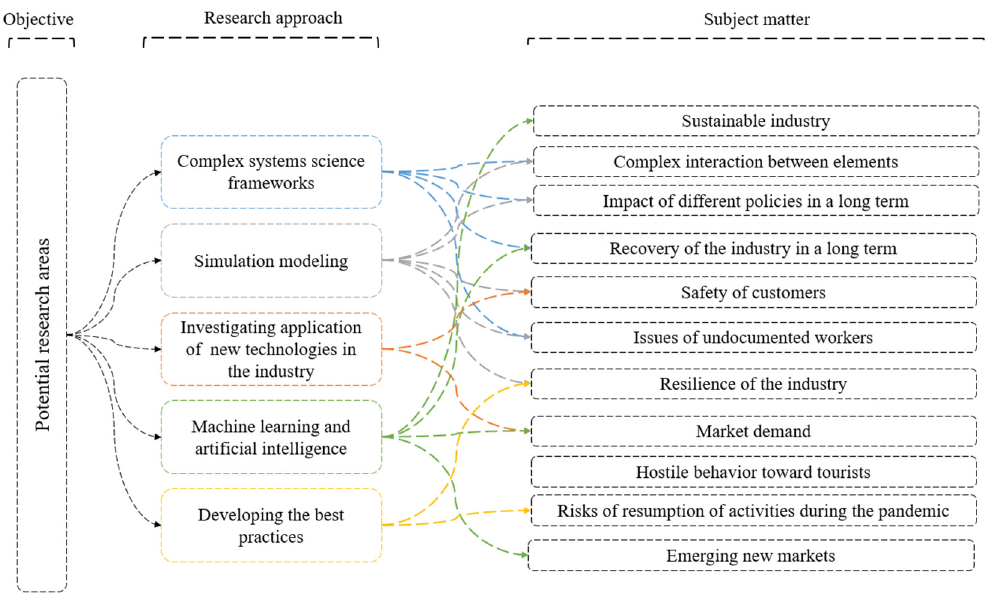
Figure 8. Future research approaches to study the hospitality industry in the face of COVID-19.